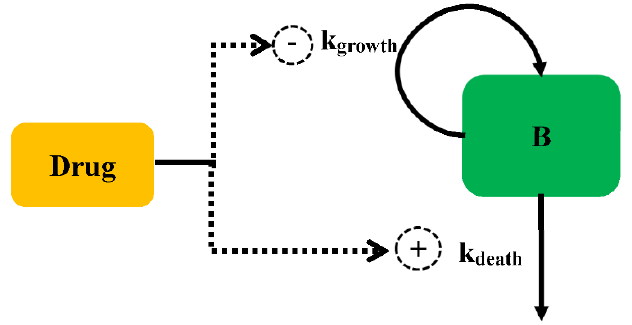
Figure 2. Schematic illustration of antibacterial effect against bacteria.